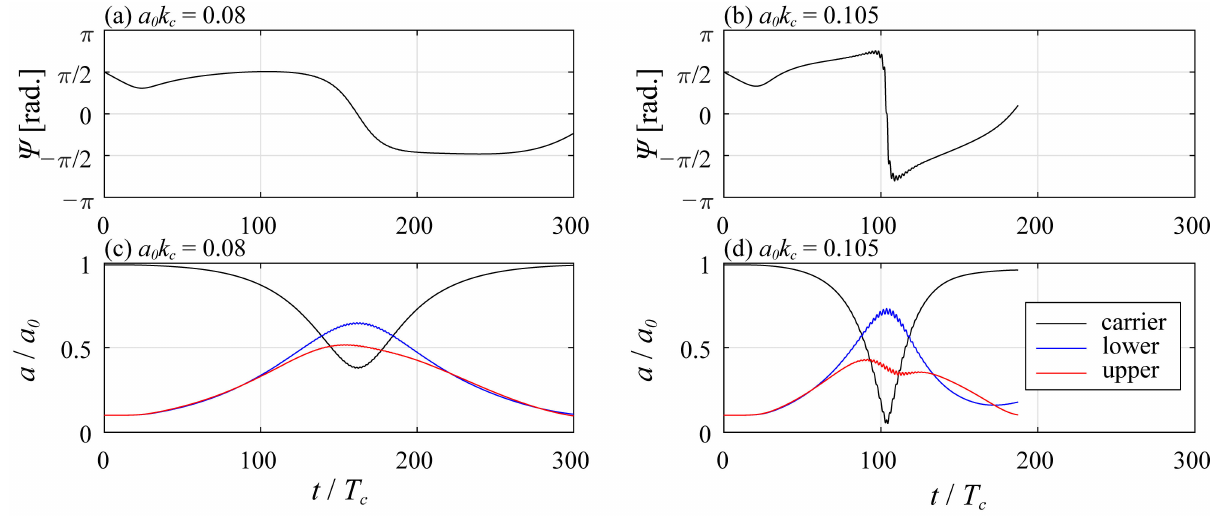
Figure 15. Long-term temporal evolutions of ( a , b ) Ψ and ( c , d ) the amplitudes of the carrier, lower- sideband, and upper-sideband components of the modulated wave train with a 0 k c = 0.08 ( a , c ) and 0.105 ( b , d